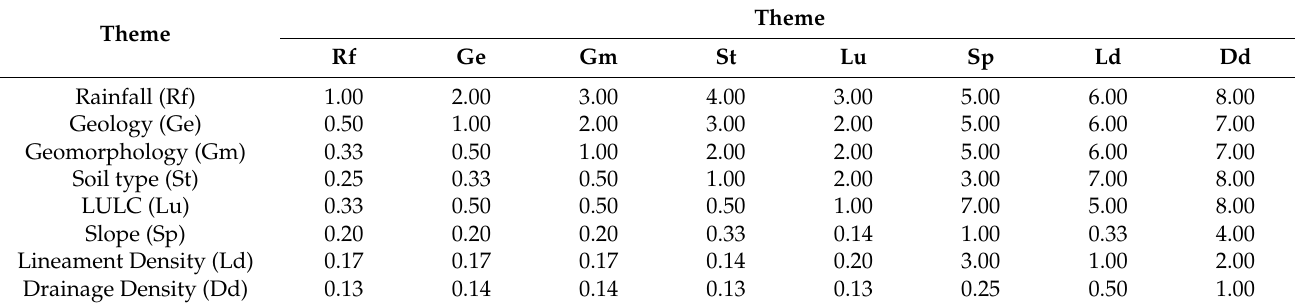
Table 3. Pairwise comparison matrix for the AHP